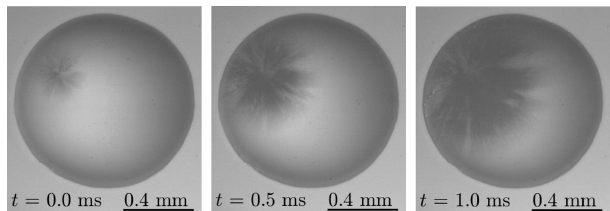
Figure 7. Top-view image sequence of dendritic freezing of a ses- sile supercooled water droplet with d = 1 . 02mm (wetted substrate area), captured using a high-speed video camera. Ice nucleation in- side the droplet at a temperature of ϑ = − 22 . 65 ◦ C is followed by dendritic freezing of the supercooled water droplet. Note that al- though the shown droplet is not exposed to an electric field, the present experimental setup allows examination of that